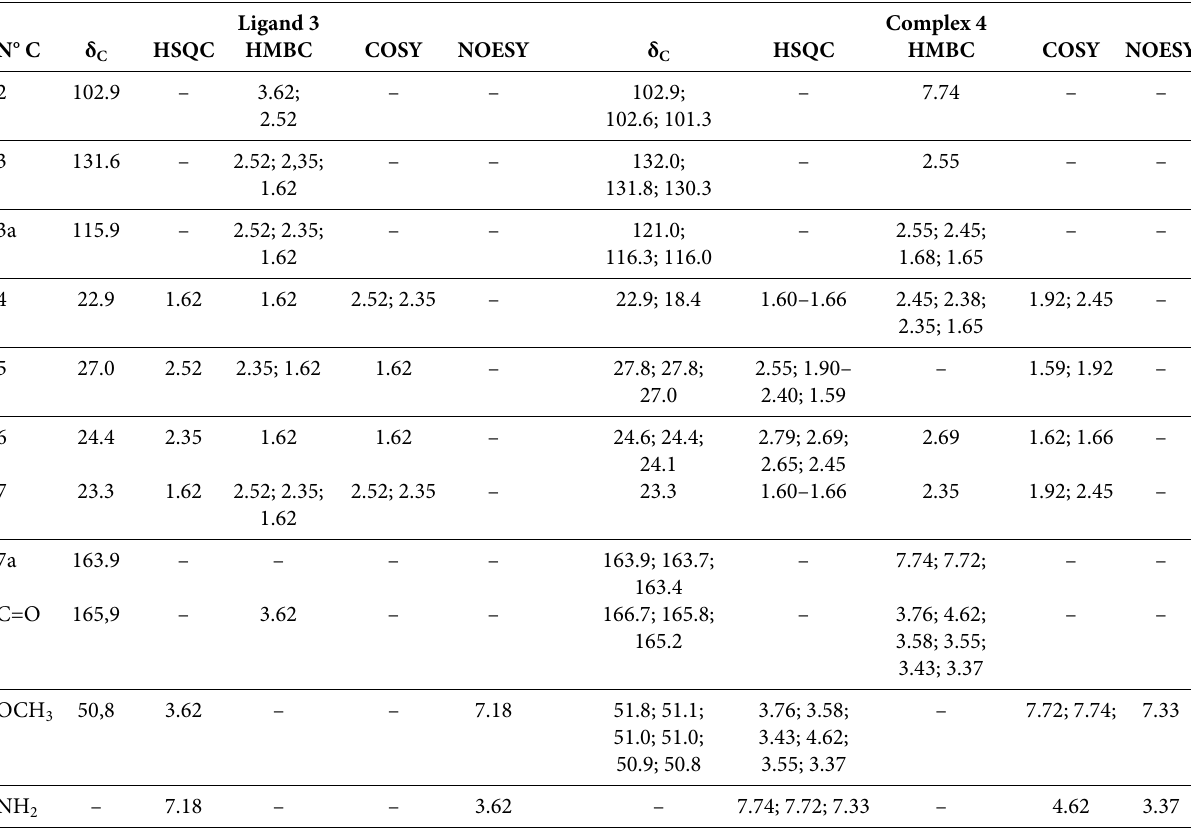
Table 2: Comparison of the interactions in the 1 H and 13 C-2D-NMR (DMSO-d 6 ) spectra of the ligand 3 with those of the complex 4